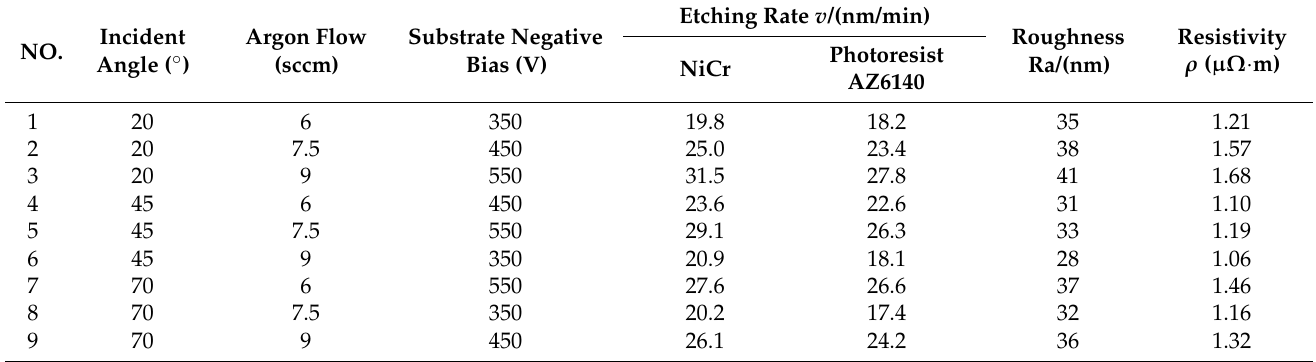
Table 7. Orthogonal experimental design and experimental results of ion beam